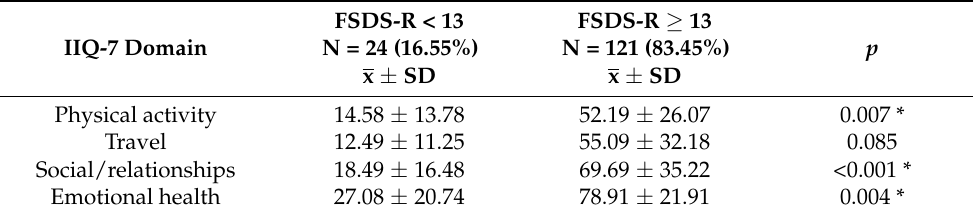
Table 6. Analysis of the IIQ-7 domains for two groups of women—satisfied with their sex life (FSDS-R < 13) and dissatisfied with their sex life (FSDS-R ≥ 13).